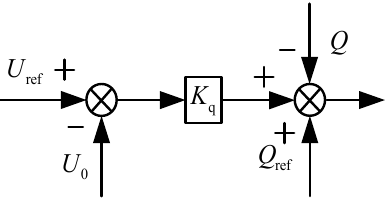
Figure 5. Control block diagram of synchronous generator excitation regulator. The reactive power–voltage control block diagram of the virtual synchronous gener- ator is shown in Figure 6. The terminal voltage command value generated by the excita- tion regulator is input into the stator electrical equation, and the current command value is generated combined with the active power–frequency adjustment loop. The generated current command value is used as the set value of the outer current loop. The control principle block diagram of the virtual synchronous generator is shown in Figure 7.